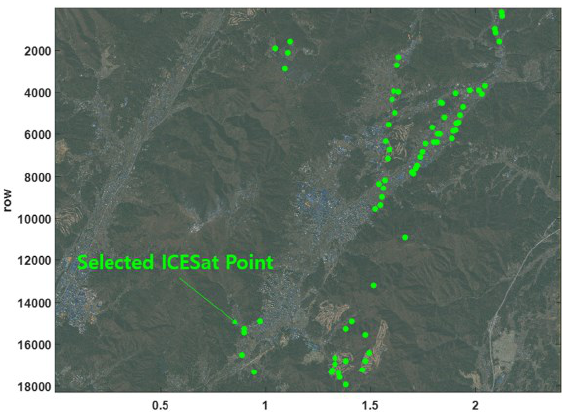
Figure 6. Distribution of the selected ICESat points (green dots)